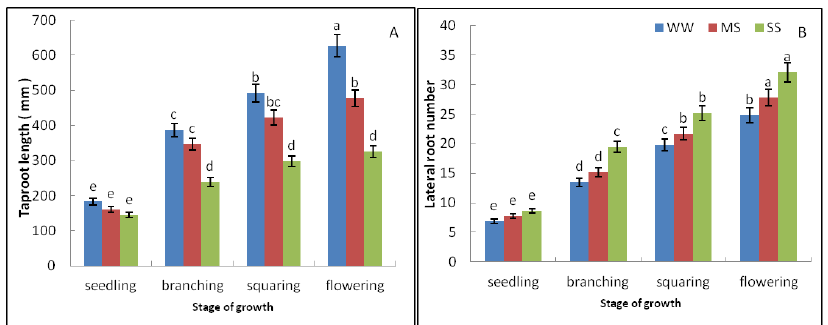
Figure 2. Effect of watering treatment (WW: water-sufficient (85% PC), MS: moderate water stress (65% PC), and SS: severe water stress (45% PC)) on ( A ) taproot length and ( B ) lateral root number per plant at four growth stages: seedling, branching, squaring, and flowering. The bars are ± one standard error of the mean ( n = 4). Different lowercase letters represent significant differences at P < 0.05 according to Tukey ’s multiple range test .